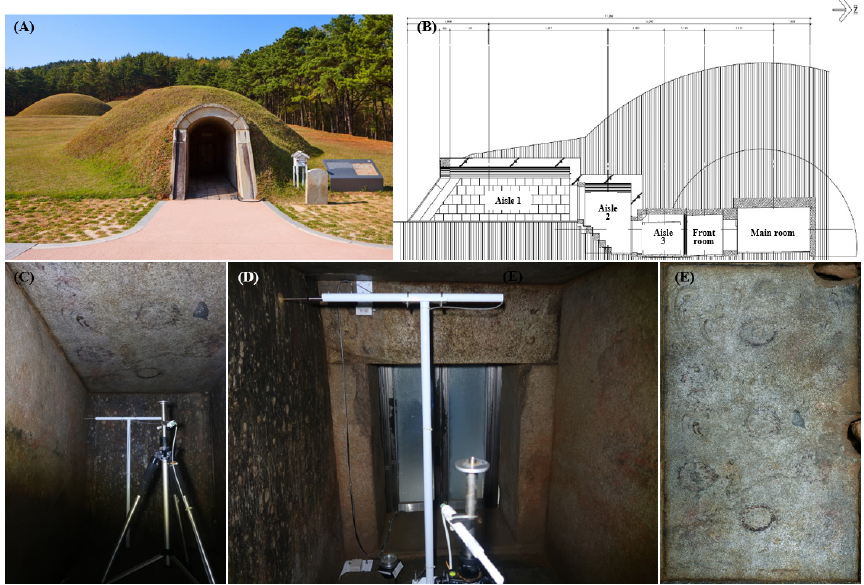
Figure 1. Photographs and structure of Buyeo Royal Tomb No. 1. ( A ) Panoramic view, ( B ) interior structure, ( C ) main room (orientation: south to north), ( D ) main room (orientation: north to south), and ( E ) a representative mural painting on the ceiling.